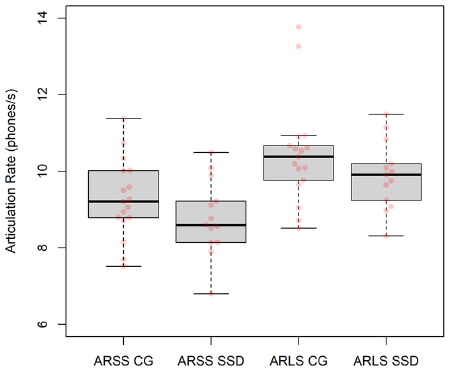
articulations ( left ), each place of articulation ( right ) and group (CG and SSD).